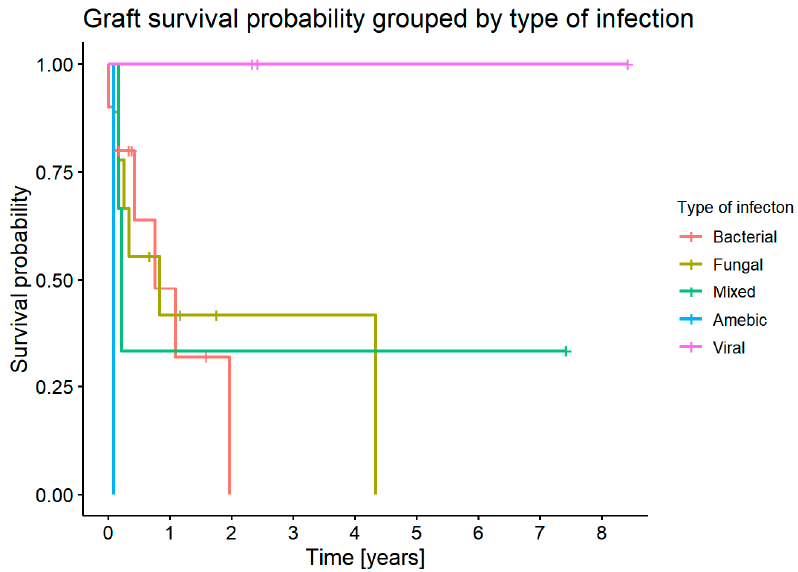
Figure 14. Graft survival probability for each type of infection.